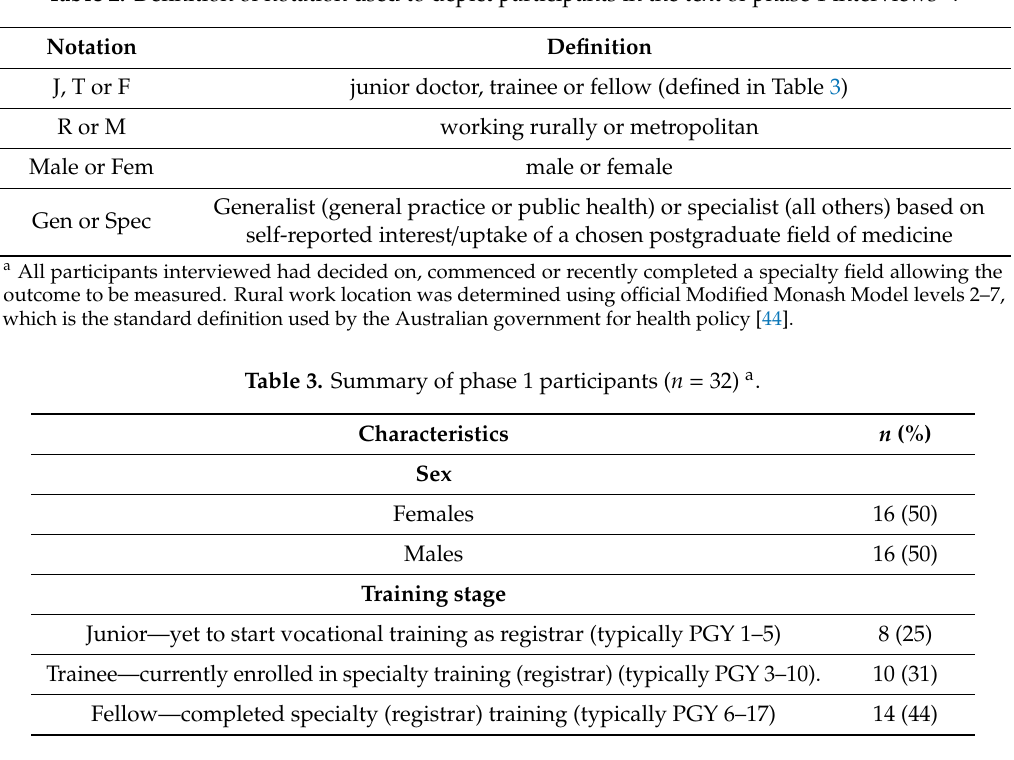
Table 2. Definition of notation used to depict participants in the text of phase 1 interviews a .